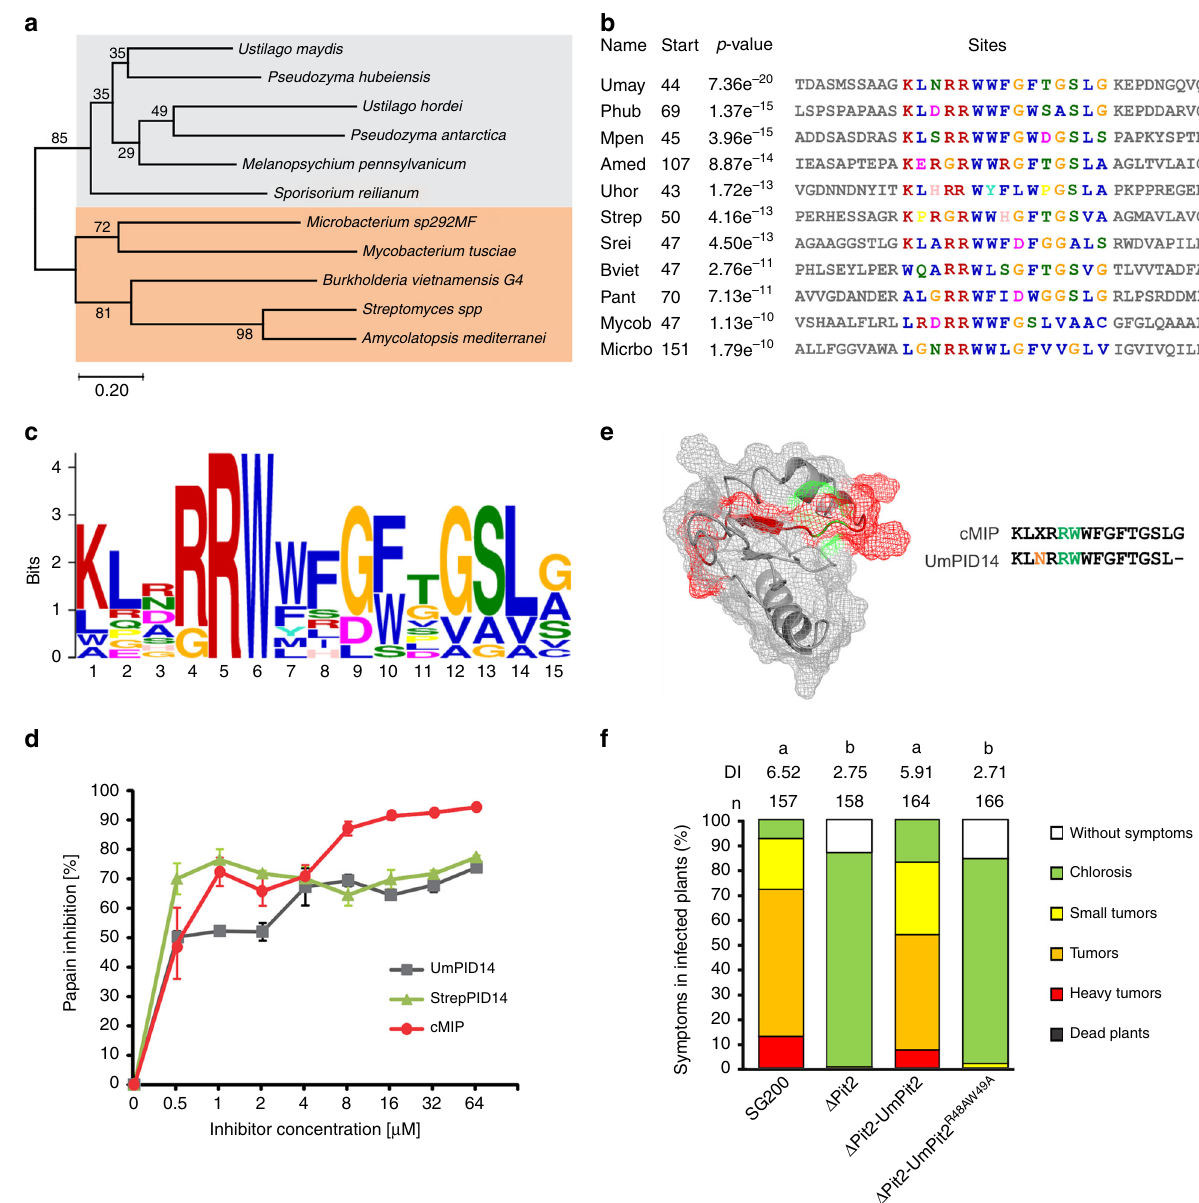
Fig. 7 PID14 is conserved in bacteria and fungi and its function depends on two amino acids. a Pit2 evolutionary relationships of sequences found in bacteria and fungi. Using blastp and the Pit2 sequence from U. maydis as template, 11 homologous sequences were found in bacteria and fungi. Their evolutionary history was inferred using the Minimum Evolution method. The optimal tree with the sum of branch length = 6.46244084 is shown. The percentage of replicate trees in which the associated taxa clustered together in the bootstrap test (2000 replicates) is shown next to the branches. b PID14 is the most conserved motif in Pit2 sequences. The 11 Pit2 sequences were used for a search of sequence motifs using MEME. Extracted sequences that are part of the motif are shown. c Conserved microbial inhibitor of proteases (cMIP). Icelogo representing the most conserved amino acids made of 11 sequences found in bacteria, yeast and smut fungi containing the cMIP motif using MEME. cMIP appears to be similar to UmPID14 except there is one more amino acid at the end of the motif. d Inhibitory pro fi le of bacterial and fungi cMIPs against papain. The activity of papain was determined using the fl uorogenic substrate Z-Phe-Arg-AMC. Values without inhibitor were set to 100% activity. UmPID14 (gray), StrepPID14 (green) and cMIP (orange) inhibition of papain was monitored in a concentration range between 0 and 64 µ M. Log inhibitor concentrations were plotted against papain activity. Error bars represent the standard deviation of three replicates. Shown is a representative plot of fi ve independent replicates showing similar results. e UmPit2 structural model representing the PID14 motif (red) and the localization of the most conserved amino acids RW (green) found in cMIP. UmPID14 and cMIP sequence comparison. In red dissimilar amino acids and in green the conserved RW. e UmPit2 structural model representing the PID14 motif (red) and the localization of the most conserved amino acids RW (green) found in MEME. f Disease rating of maize seedlings at 12 dpi infected with U. maydis SG200 strain, Δ Pit2 mutant and complemented Δ Pit2 strains with UmPit2 ( Δ Pit2-UmPit2) and the mutant strain Δ Pit2-UmPit2 R48AW49A ,